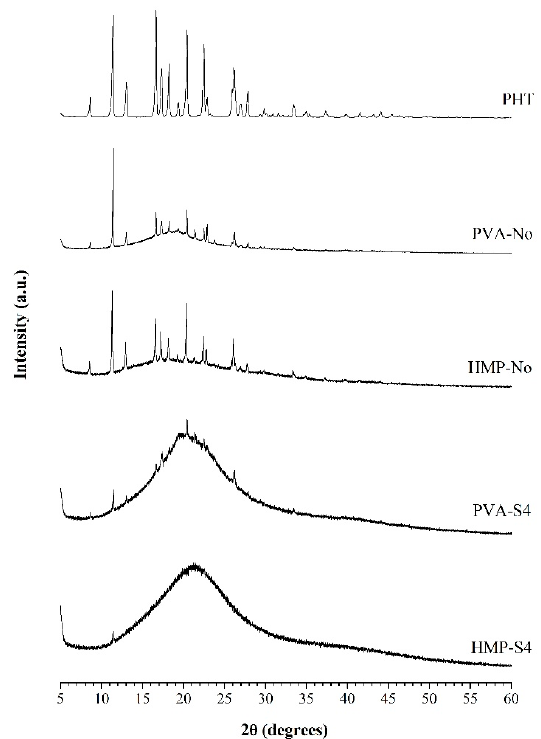
Figure 3. X-ray di ff raction patterns of PHT (phenytoin), PVA-No, HMP-No, PVA-S4 and HMP-S4 Figure 3. X-ray diffraction patterns of PHT (phenytoin), PVA-No, HMP-No, PVA-S4 and HMP-S4 ODFs.